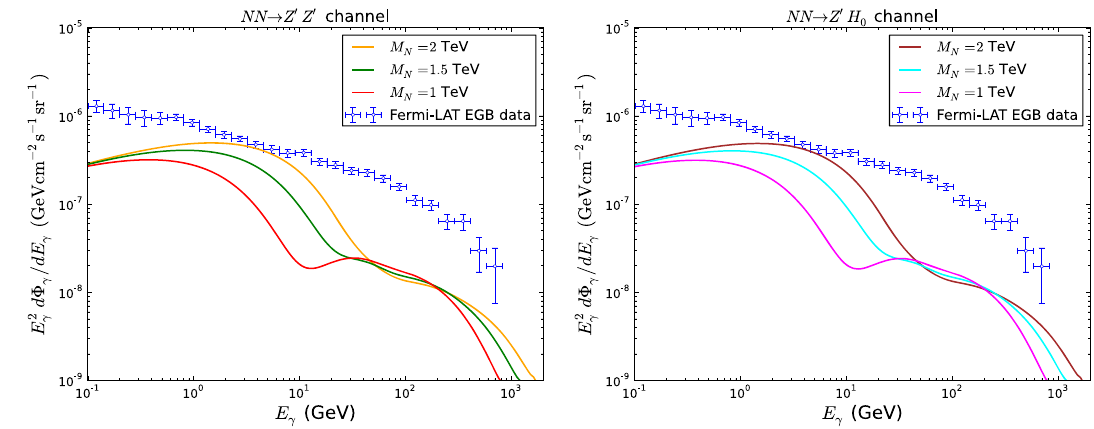
Fig. 9 Comparison of the EGRB flux produced by benchmarks in Tables 3 and 4 with the Fermi-LAT measurements